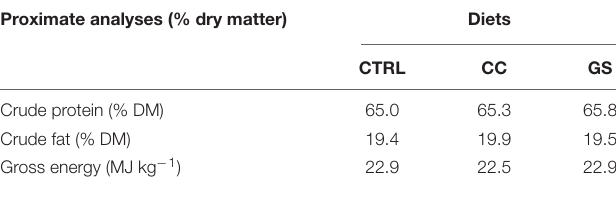
TABLE 1 | Proximate analyses of the experimental diets. Proximate analyses (% dry